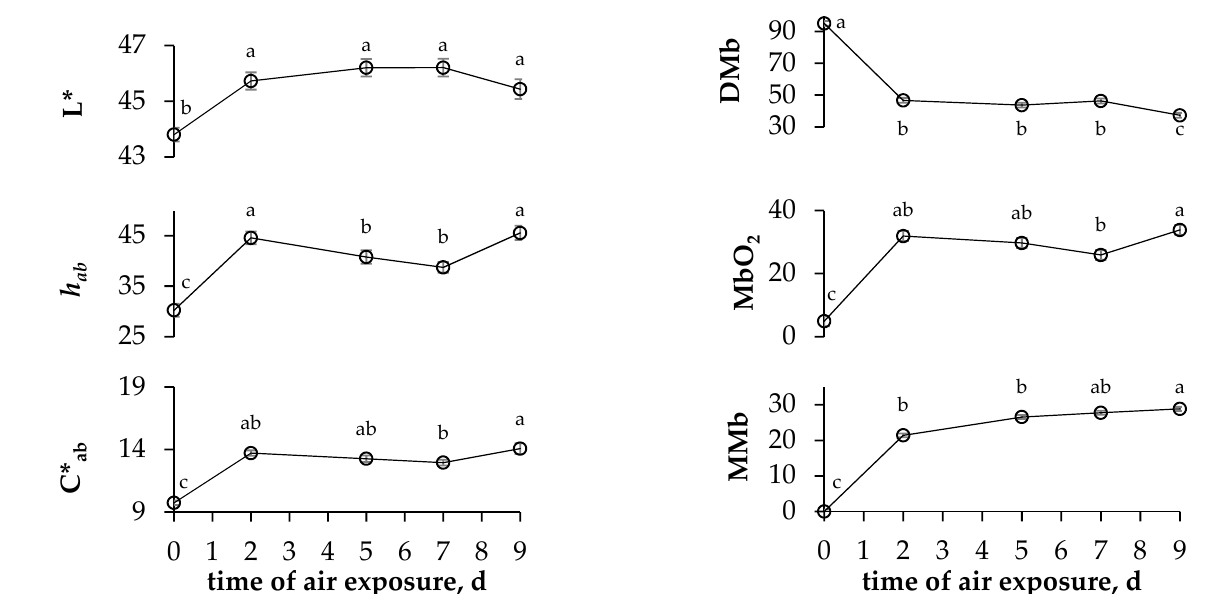
Figure 1. Evolution of colour parameters (lightness ( L* ), hue angle ( h ab ) and chroma ( C* ab )) and haem pigments (deoxy- myoglobin ( DMb ), oxymyoglobin ( MbO 2 ) and metmyoglobin ( MMb )) of LTL muscle throughout display. Vertical bars indicate the standard error of the mean; different letters indicate differences between times ( p < 0.05).